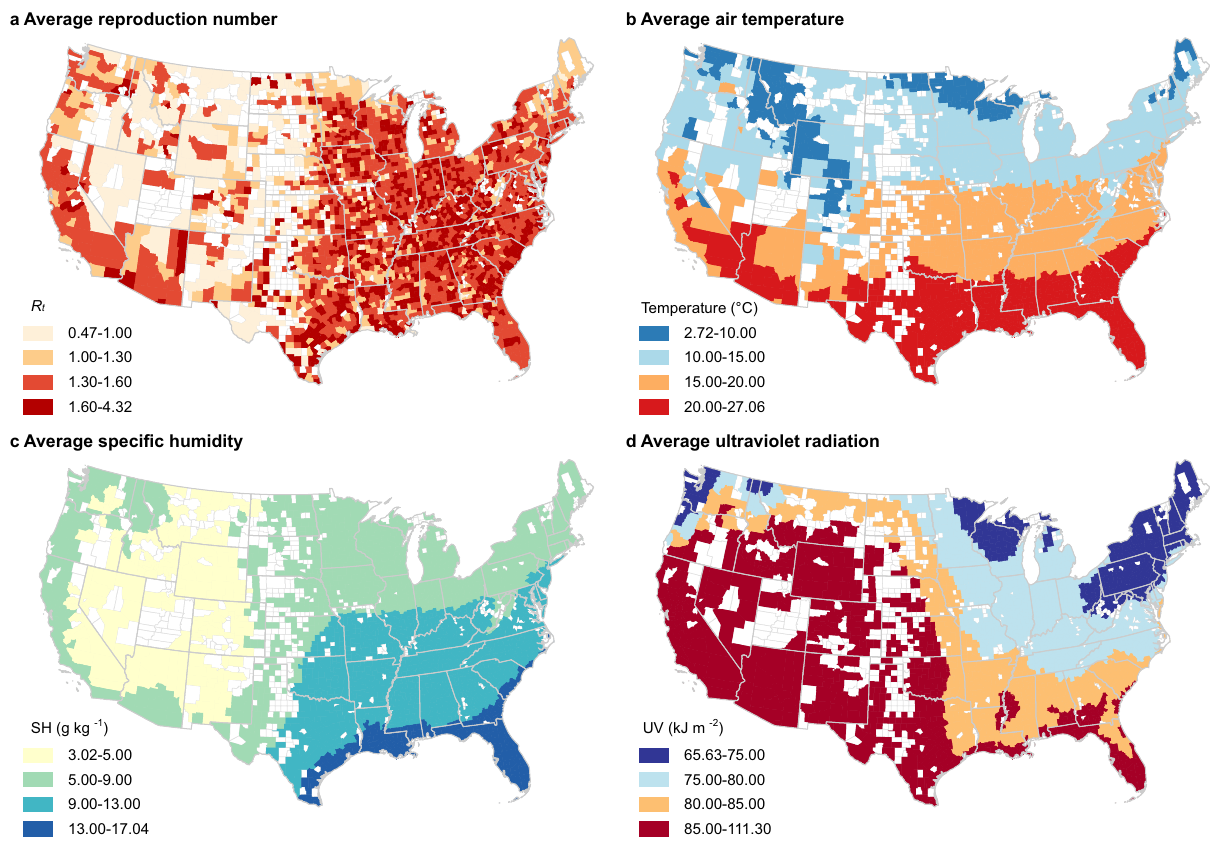
Fig. 1 Map of the distribution of reproduction number, air temperature, speci fi c humidity, and ultraviolet radiation in study counties. This fi gure displays the distribution of key variables averaged over the study period in 2669 U.S. counties. a The distribution of the daily reproduction number ( R t ). b The distribution of daily air temperature. c The distribution of daily speci fi c humidity (SH). d The distribution of daily ultraviolet (UV) radiation. The shape fi le in the maps was obtained from the U.S. Census